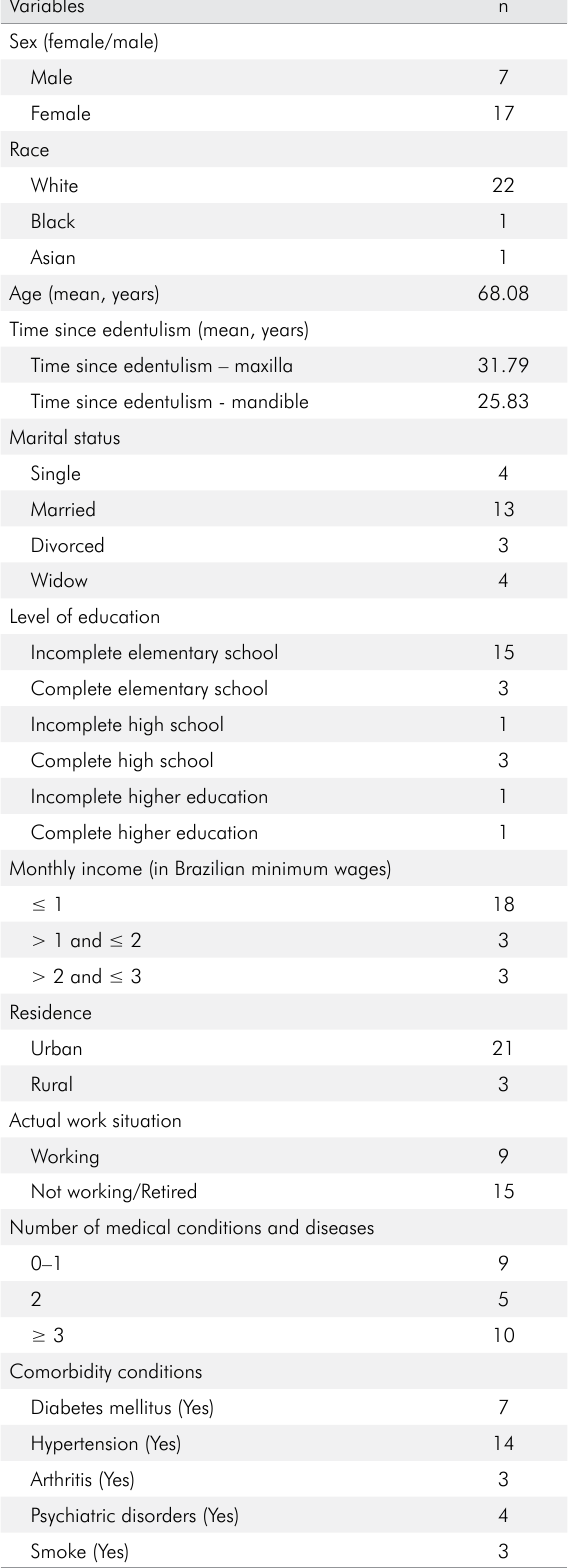
Table 1. Socio-demographic information of the